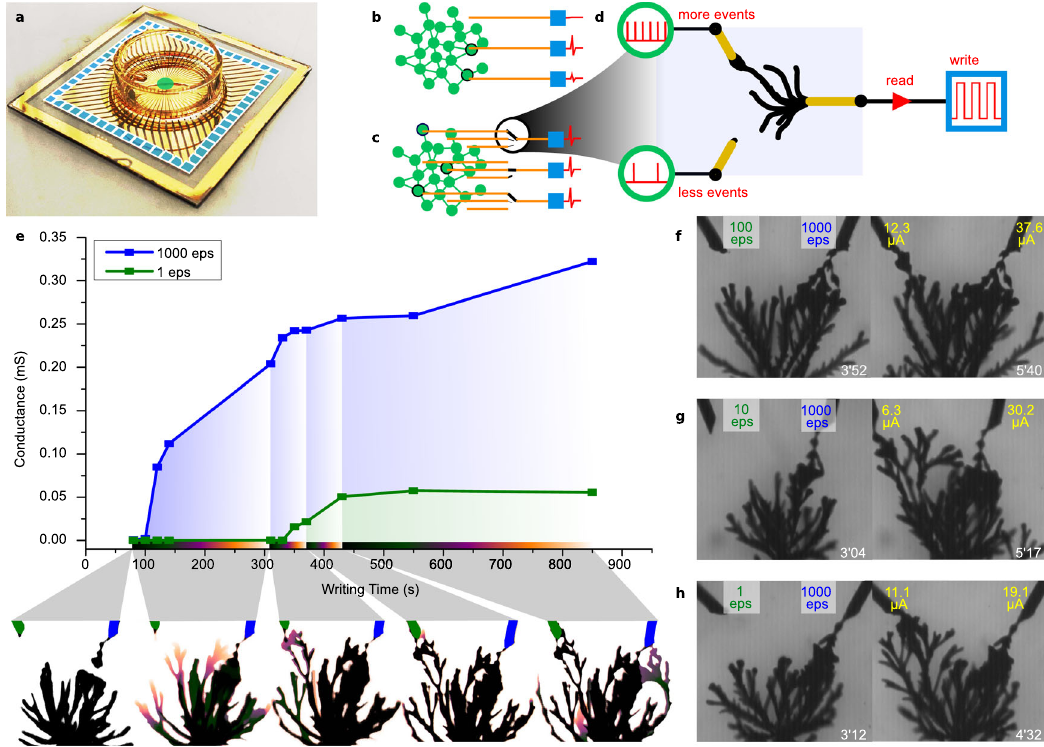
Fig. 6 Hardware-based sensing-array dimensionality reduction via event-based dendritic interconnectivity. a Multi-Electrode Array (MEA) as an example for high-dimensional electro-sensitive hardware with no computing layer between the neural culture (input in green) and the restricted number of electrical contacts (output in blue). b Illustration for the poor readout of an unprogrammable array to ef fi ciently sense active cells and collect relevant information. c Concept of using electrical event-based dendritic interconnectivity to program an array to self-connect an output to the most electro-active inputs. d Using electropolymerization as an electrochemical-PROM, the morphology created upon the polarization of the output to an appropriate waveform (writing), shall promote a speci fi c morphology that favors earlier and higher conduction (read) interconnectivity towards the sensing input that has experienced most unipolar activity. e Temporal evolution of the conductance of a three-wire junction (2INx1OUT), where both inputs are stimulated at a different number of events per second (eps, one event being 200mV vs. GND for 0.5ms) and the output wire stimulated at V p = 2.9V, V off = 1.1V, f = 80Hz, dc = 40%. At the bottom is displayed the color-encoded images of the growths displaying the different phases of completion responsible for the fastest-and-highest interconnectivity of the output to the input that experiences the highest number of event per second. f – h Three-wire junction (2INx1OUT) growths that compare the interconnectivity competition between one sensing input experiencing 1000 eps (200mV vs. GND, 0.5ms) and one sensing input experiencing 100 eps (200mV vs. GND, 0.5 ms f ), 10 eps (200mV vs. GND, 0.5ms g ) and 1 eps (200mV vs. GND, 0.5ms h ) with output continuously polarized at V p = 2.9V, V off = 1.1V, f = 80Hz, dc = 40%. Scatters, curves, and labels ’ color encodings within e , f , g and h are identical, so green depicts the electrode experiencing the lowest rate of activity, while blue depicts the electrode experiencing the highest rate of activity in